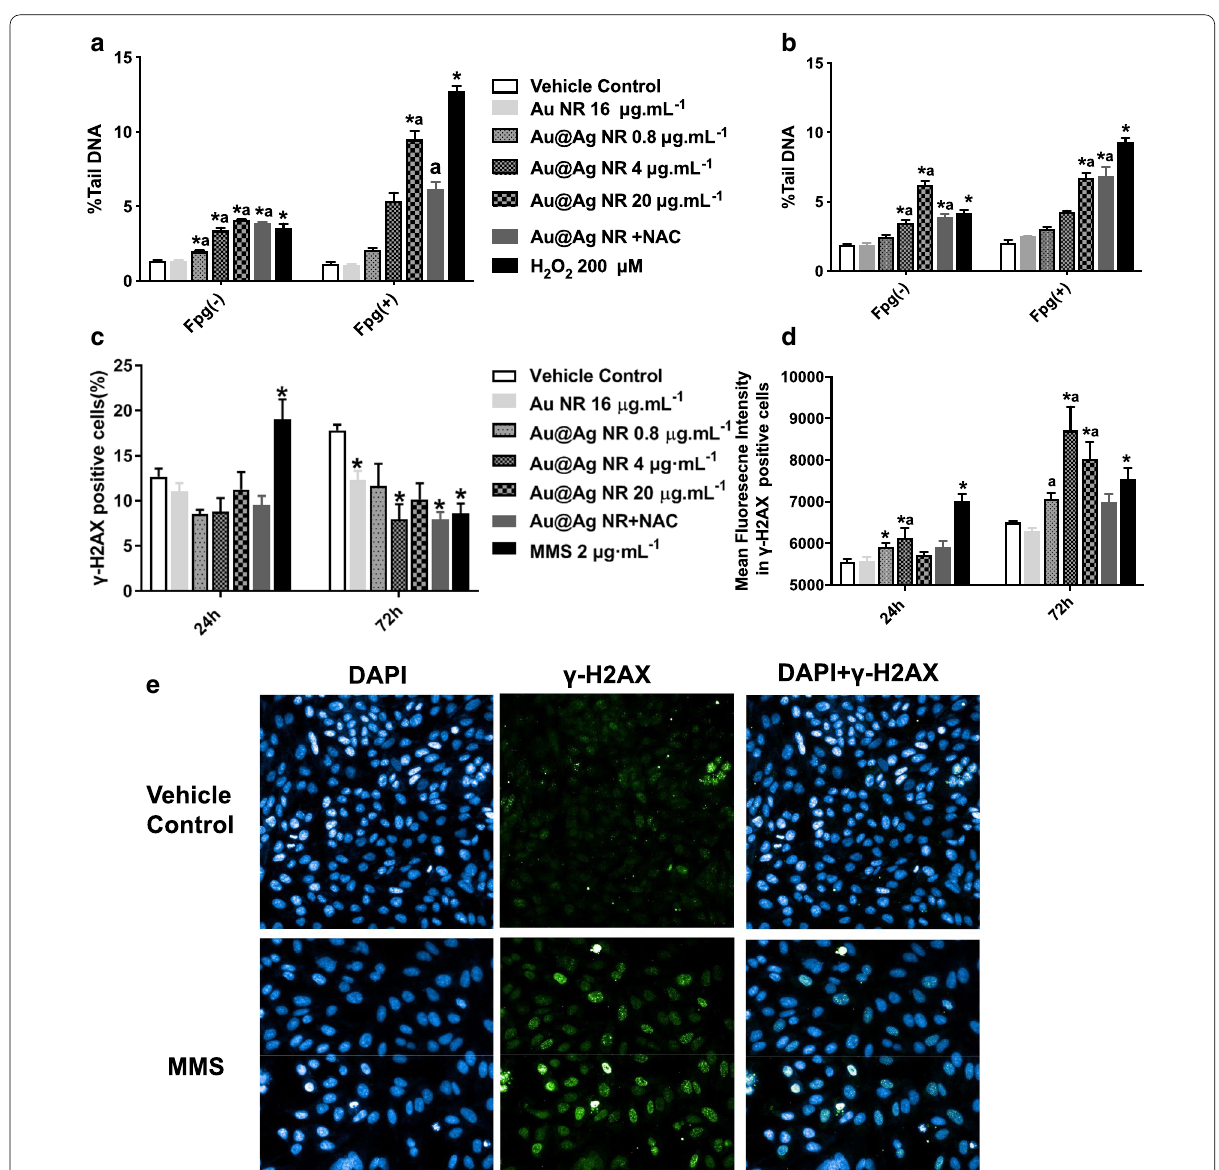
Fig. 3 DNA damage induced by Au@Ag NR. HepaGR cells were exposed to Au@Ag NR at different concentrations (0.8 to 20 μg mL − 1 ) for 24 h and 72 h, respectively. a Averaged % Tail DNA after exposed to Au@Ag NR for 24 h; b averaged % Tail DNA after exposed to Au@Ag NR for 72 h; c percentage of positive cells with γ-H2AX foci estimated using flow cytometry; d mean fluorescence intensities in cells with γ-H2AX foci estimated using immunofluorescent staining. * P < 0.05 versus vehicle control; a P < 0.05 versus Au NR. 2 μM mL − 1 MMS was employed as a positive